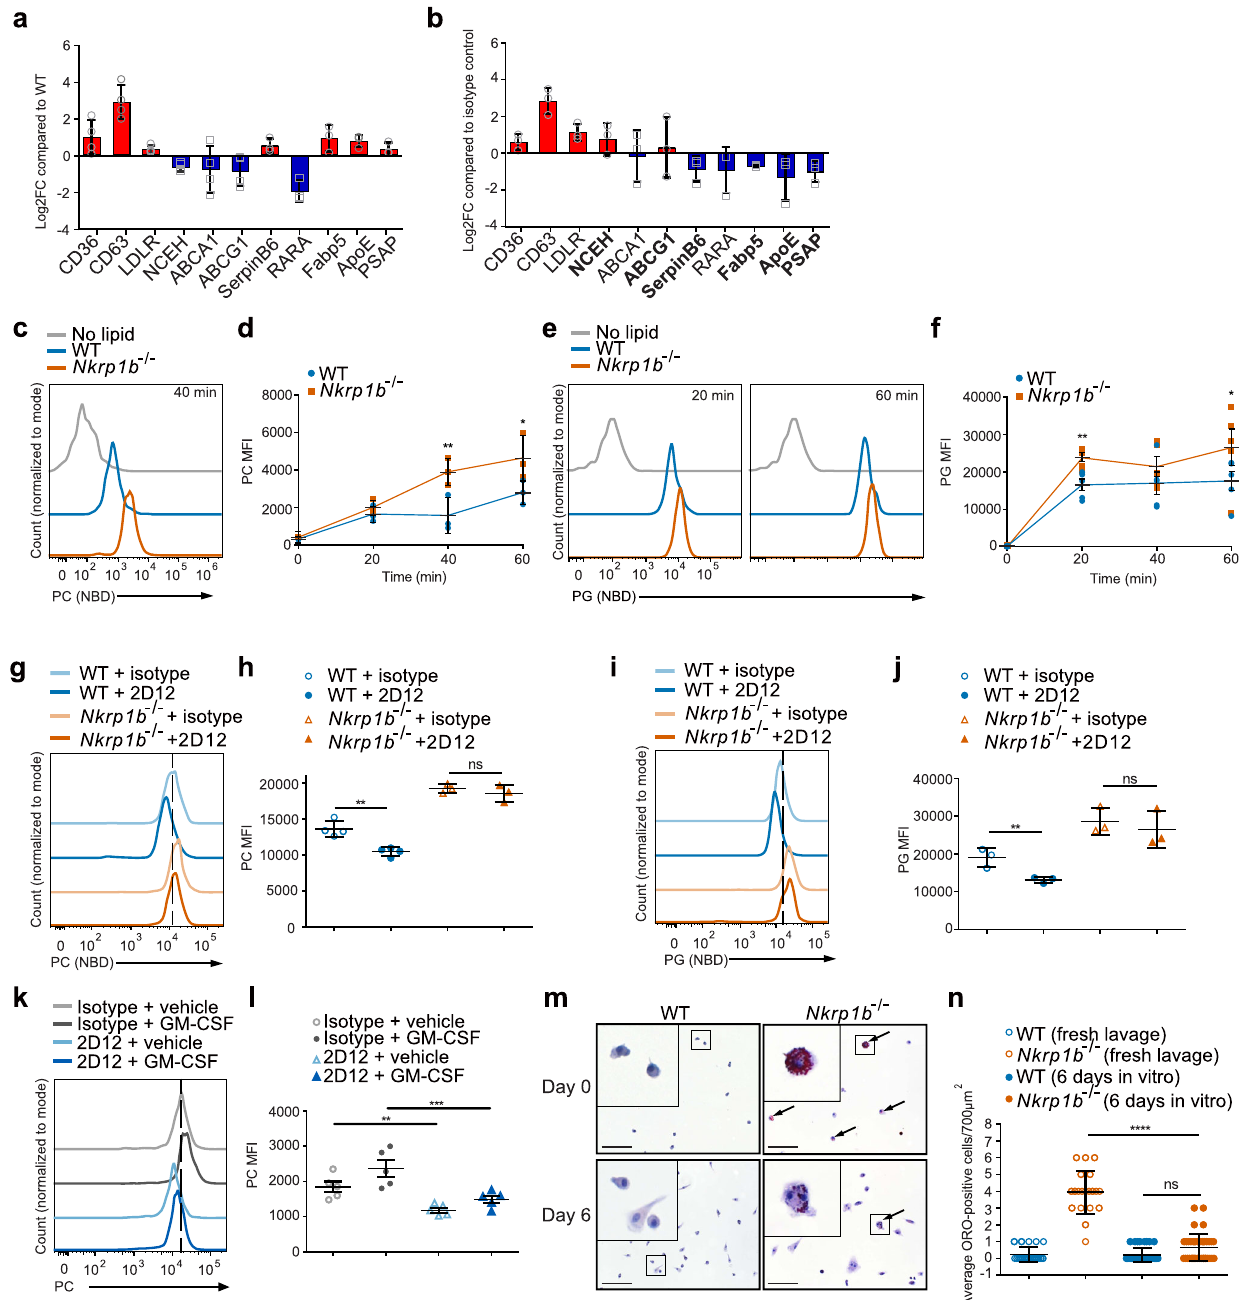
Fig. 6 | NKR-P1B signaling correlates with the rate of surfactant lipid uptake by AM. a RT-qPCR of select metabolic genes from WT and Nkrp1b − / − AM from2-week-oldmice.DatanormalizedtoWTlevels. b RT-qPCRanalysisofWTAM crosslinked with 2D12 or isotype antibody. Data normalized to isotype control. c Fluorescence of WT and Nkrp1b − / − AM after 40min NBD-PC incubation. d MFI of WT and Nkrp1b − / − AM after 0, 20, 40, and 60min NBD-PC incubation. e Fluorescence of WT and Nkrp1b − / − AM after 20 and 60min incubation with NBD- PG. f MFI of WT and Nkrp1b − / − AM after 0, 20, 40, and 60min NBD-PG incubation. g NBD-PCuptakeinWTand Nkrp1b − / − AMcrosslinked with2D12orisotype control. h MFIofNBD-PCuptakein( g ). i NBD-PGuptakeinWTand Nkrp1b − / − AMcrosslinked with2D12orisotypecontrol. j MFIofNBD-PGuptakein( i ). k NBD-PCuptakeinWT AM crosslinked with 2D12 or isotype control in the presence of GM-CSF or vehicle